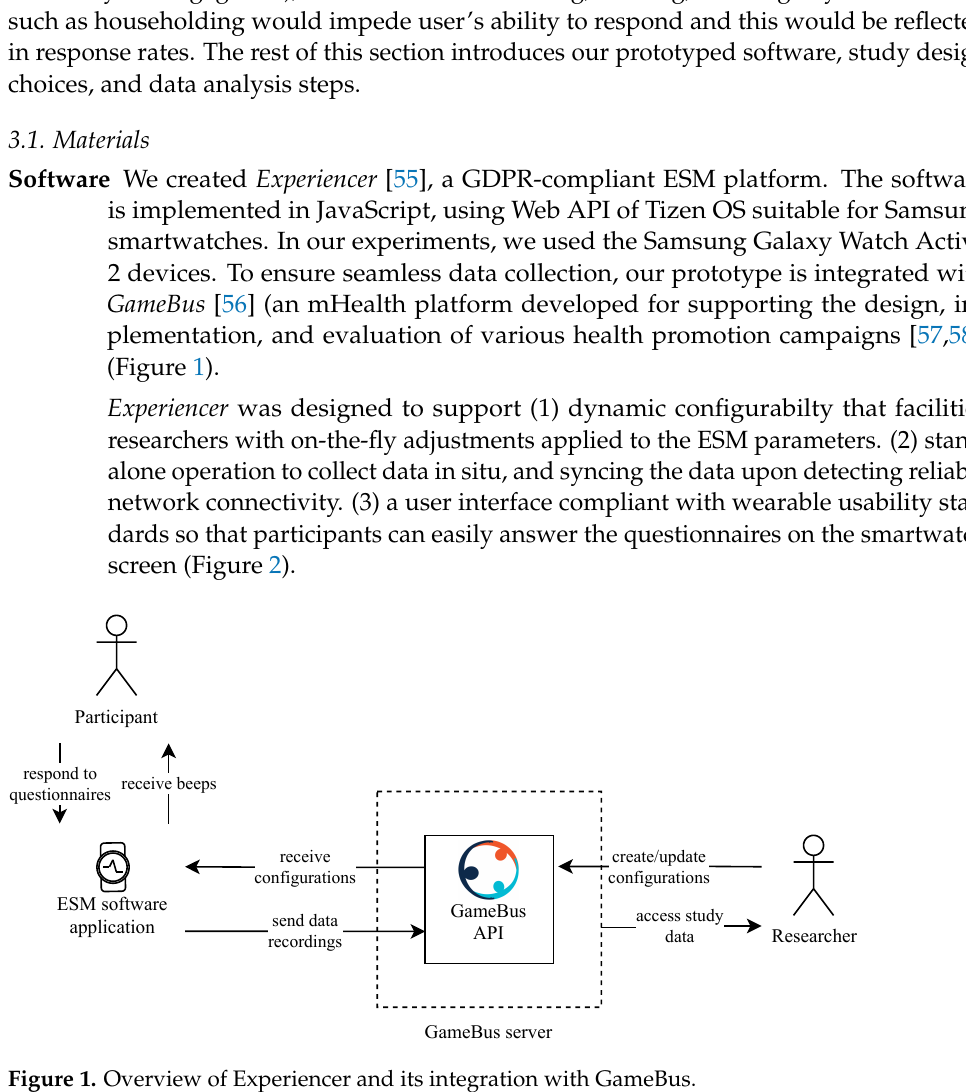
Figure 1. Overview of Experiencer and its integration with